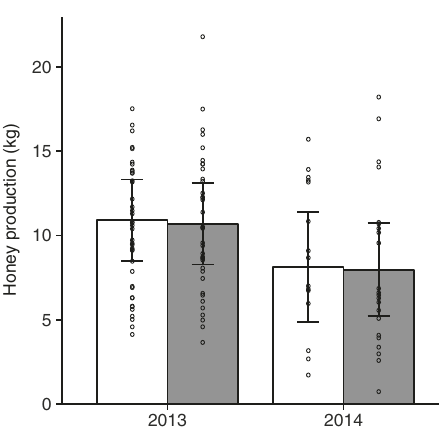
Fig. 3 Honey production. Mean (±95% con fi dence limits) honey production measured in kilogram in relation to seed treatment (control = white bars; clothianidin-treated = grey bars) during the oilseed rape bloom in two years (2013 and 2014); n = 8 fi elds per treatment in 2013 and n = 4 control fi elds and 6 clothianidin-treated fi elds in 2014. Circles indicate measured values per colony NATURE COMMUNICATIONS| (2019) 10:692